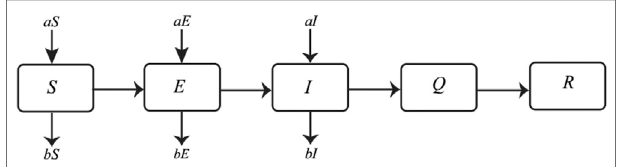
FIGURE 3 | Before the Spring Festival, the fl owcharts of COVID-19 infectious disease model. S ( t ) , E ( t ) , I ( t ) , Q ( t ) , and R ( t ) represent susceptible, exposed, infected, con fi rmed, and removed